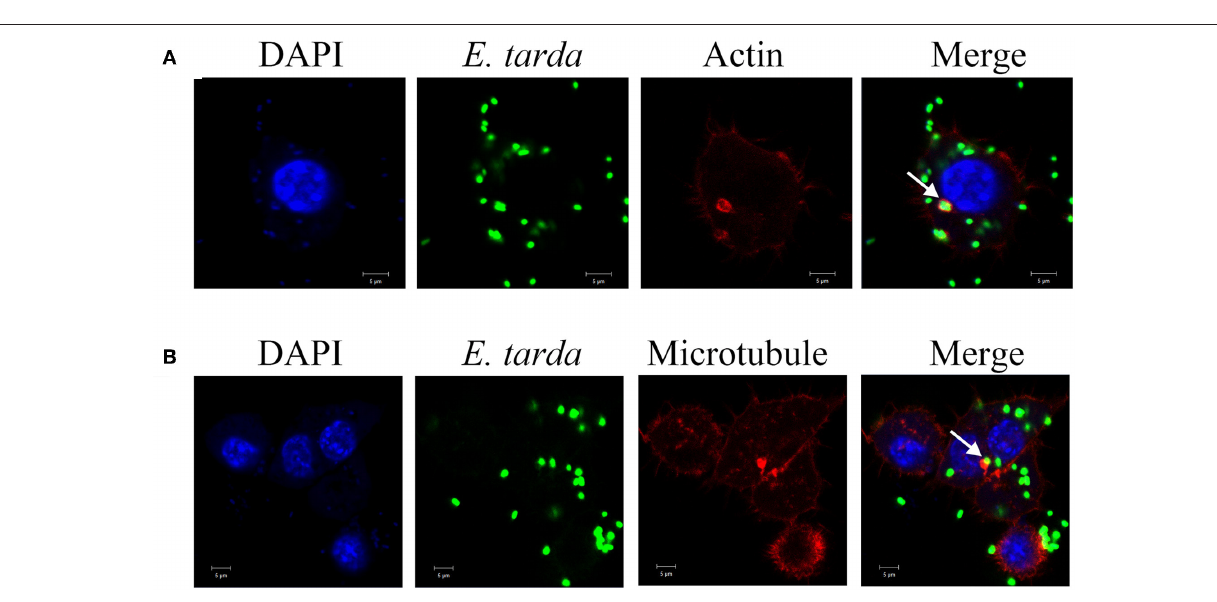
FIGURE 7 | Co-localization of actin (A) and microtubule (B) with Edwardsiella tarda in RAW264.7. RAW264.7 cells infected with E. tarda TX1G were treated with Alexa Fluor594-labeled phalloidin (A) or Tubulin-Tracker Red (B) . The cells were then observed with a confocal microscope. White arrow indicates co-localization of bacteria and actin/microtubule. Bar: 5 µ